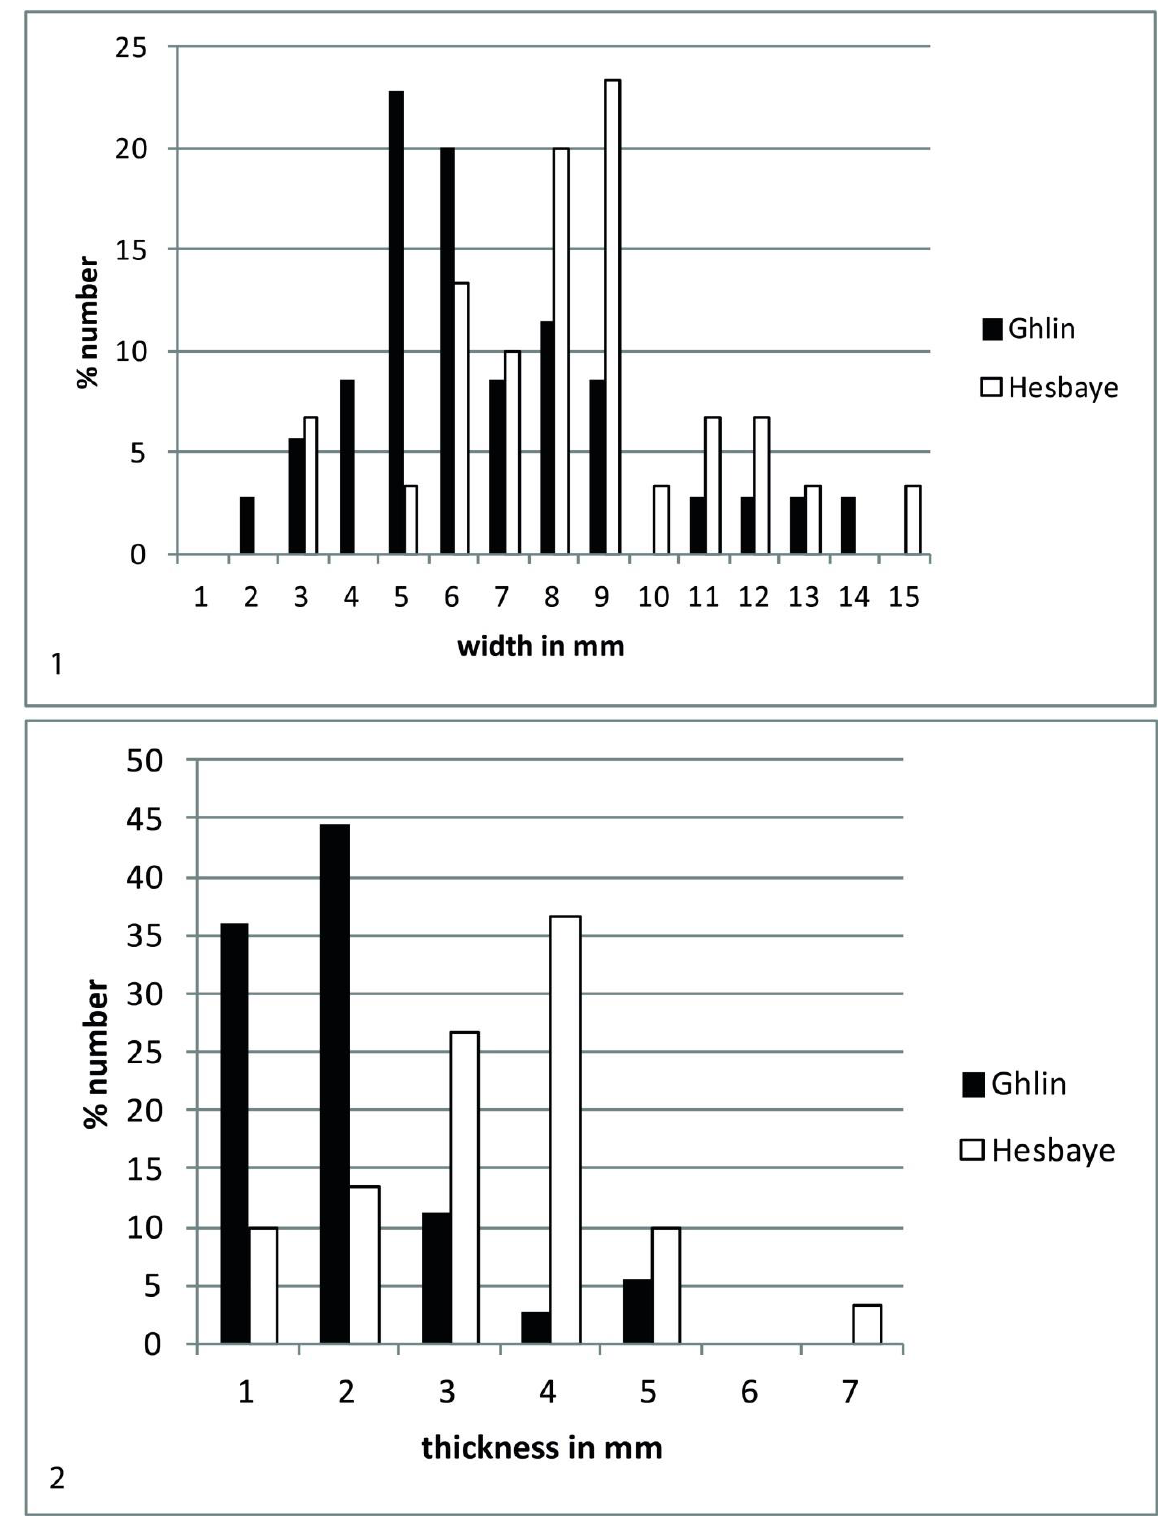
Figure 10. Comparisons between the dimensions of the butts, blades from VCM 98, 35 blades in Ghlin flint and 30 blades in fine-grained flint of Hesbaye. 1. width in mm; 2. thickness in